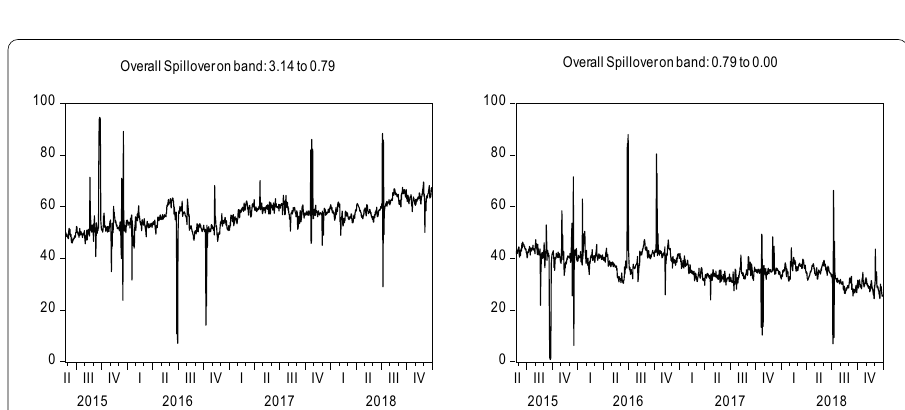
Fig. 10 Time varying frequency connectedness (250 days rolling window) of the Bitcoin markets and foreign exchange pairs of major trading currencies. Band 3.14 to 0.79 corresponds 1 to 4 days (Short Horizon) and band 0.79 to 0.00 corresponds 4 plus days to infinity (Long Horizon). The Y-axis depicts the volatility spillover values and the X-axis depicts the time